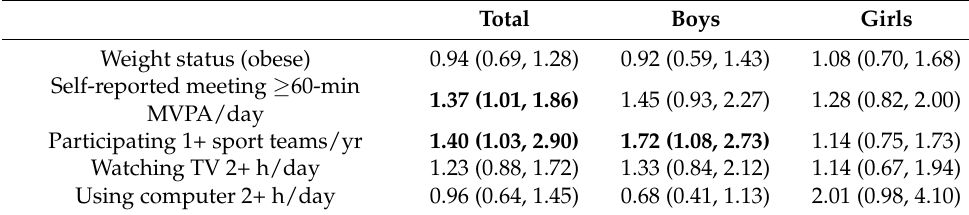
Table 5. A prediction of objectively measured meeting all-day MVPA recommendation a